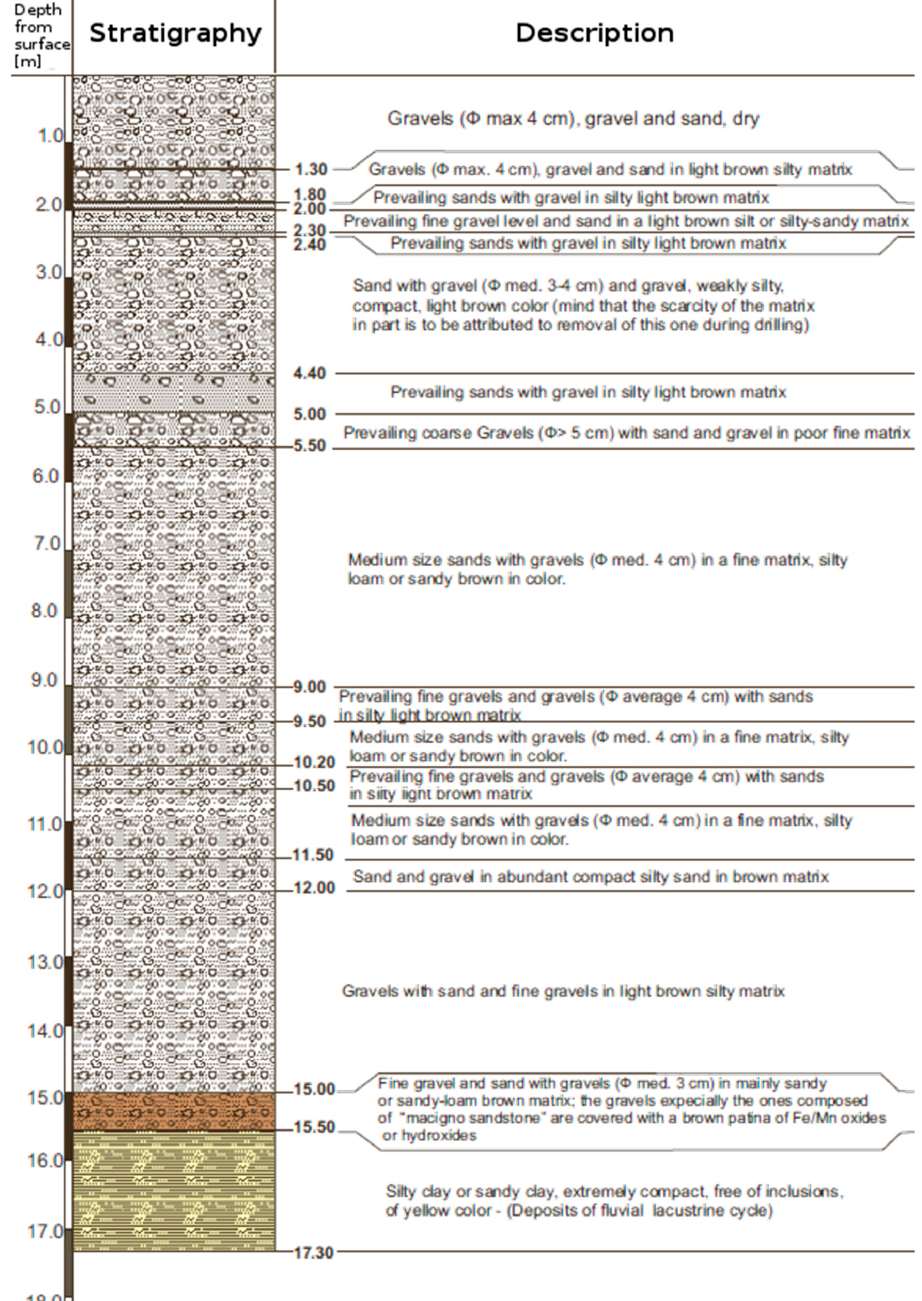
Figure 4. Stratigraphic log from the top of the Serchio river riverbed down to about 17 m.